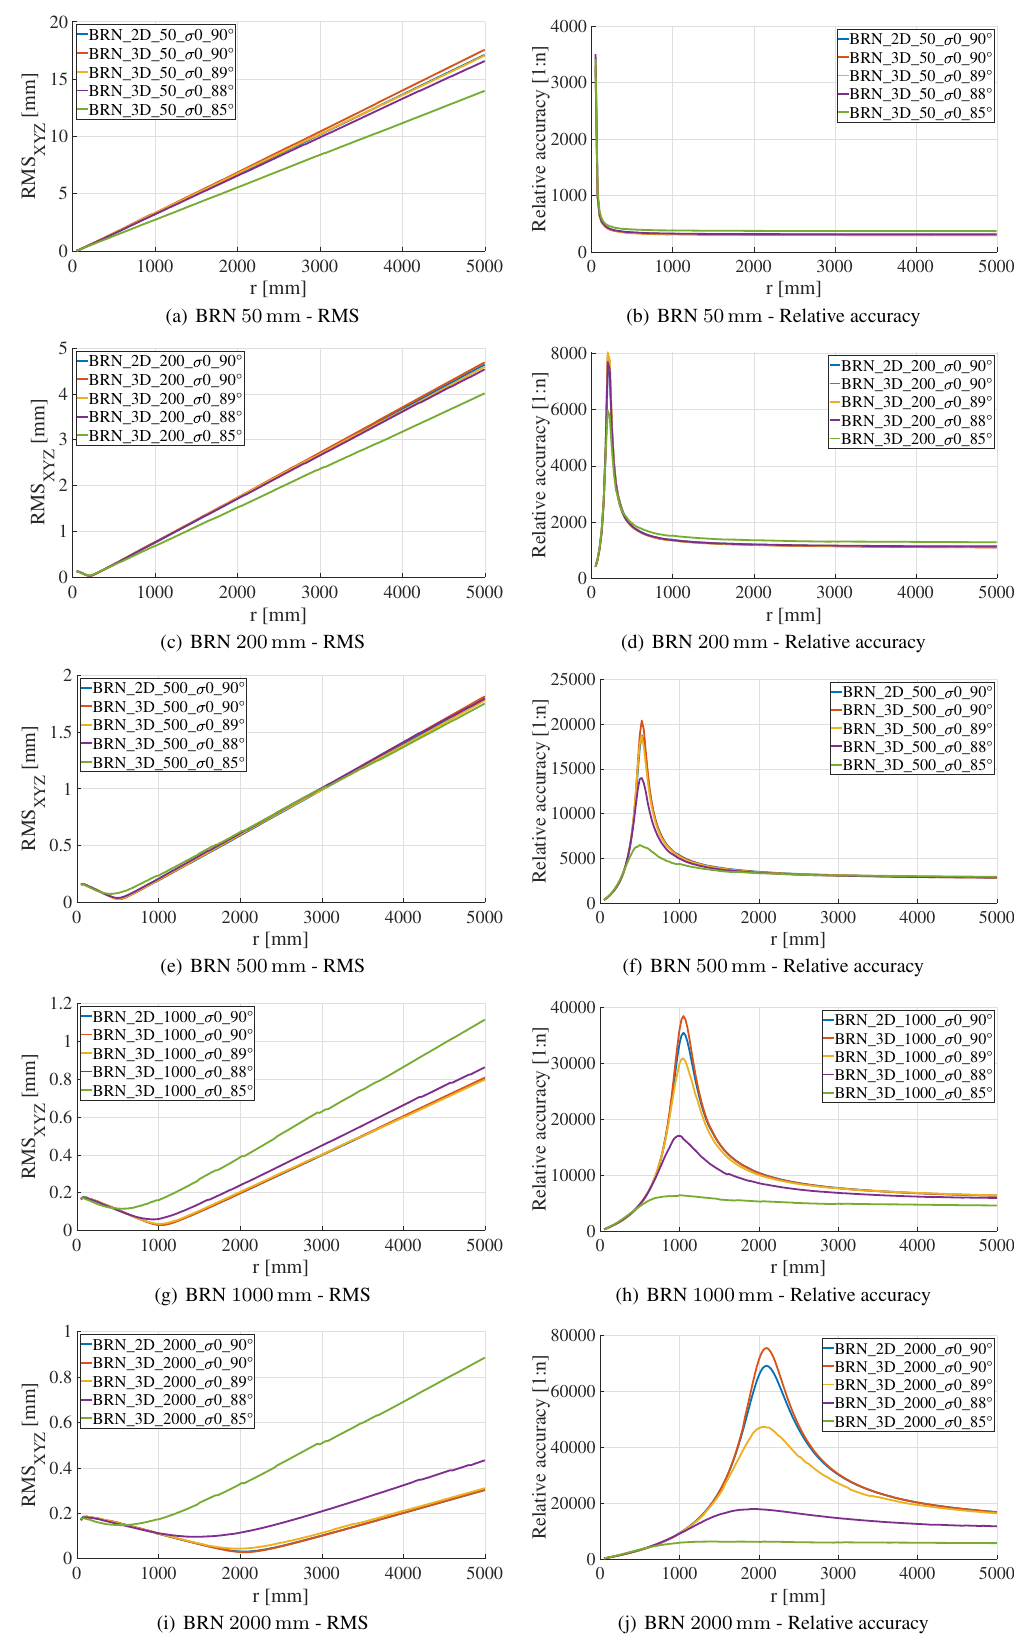
Figure 4. RMS values (left) and relative accuracy (right) of the measurement stage for calibration distances 50mm , 200mm , 500mm , 1000mm and 2000mm . All data sets were simulated without image noise and with implicit